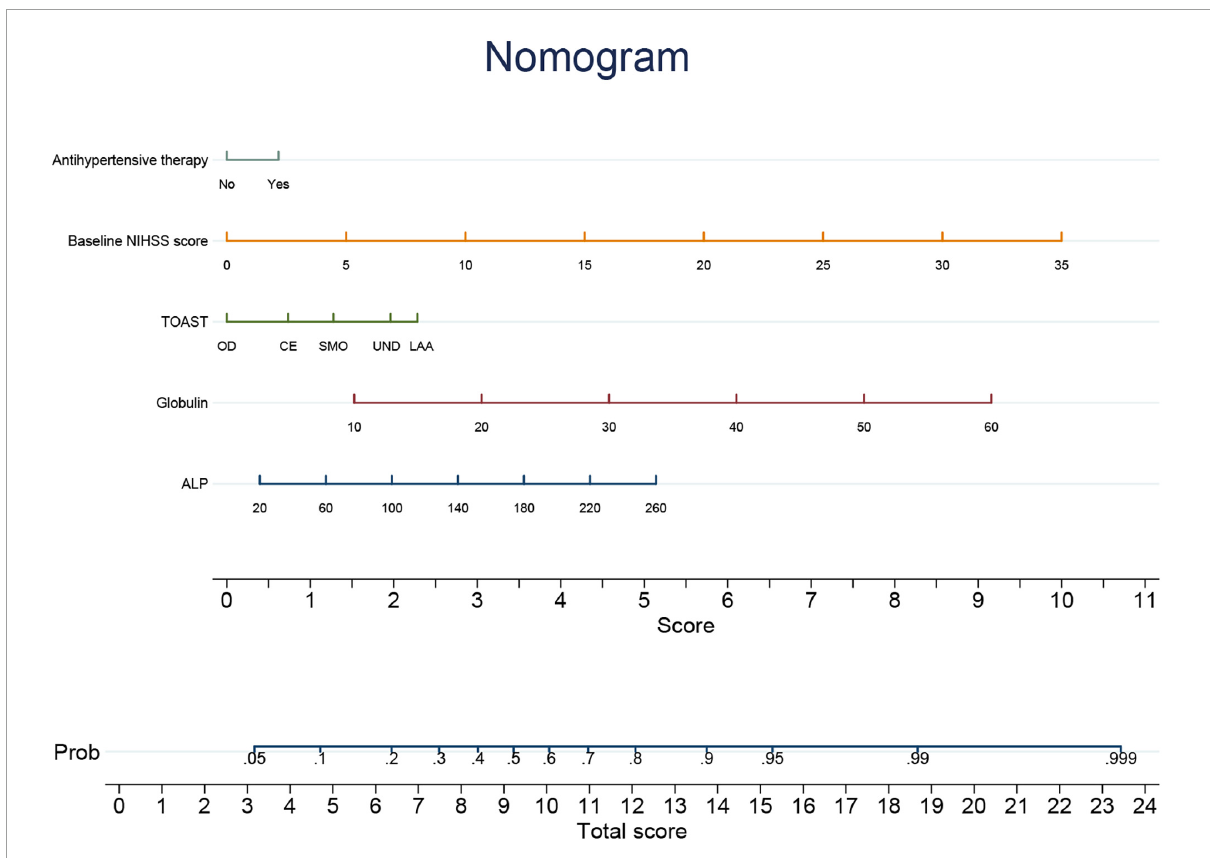
FIGURE3 Nomogram of individualized prediction model to predict 3-month poor outcome. NIHSS, National Institutes of Health Stroke Scale; TOAST, Trial of Org 10172 in acute stroke treatment; LAA, large-artery atherosclerosis; SMO, small-vessel occlusion; CE, cardioembolism; OD, other determined etiology; UND, undetermined etiology; ALP, alkaline phosphatase.